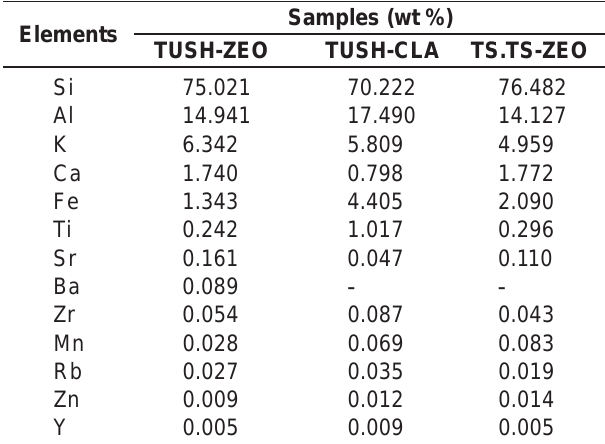
Table 2. Elemental analysis of the natural samples measured by XRF